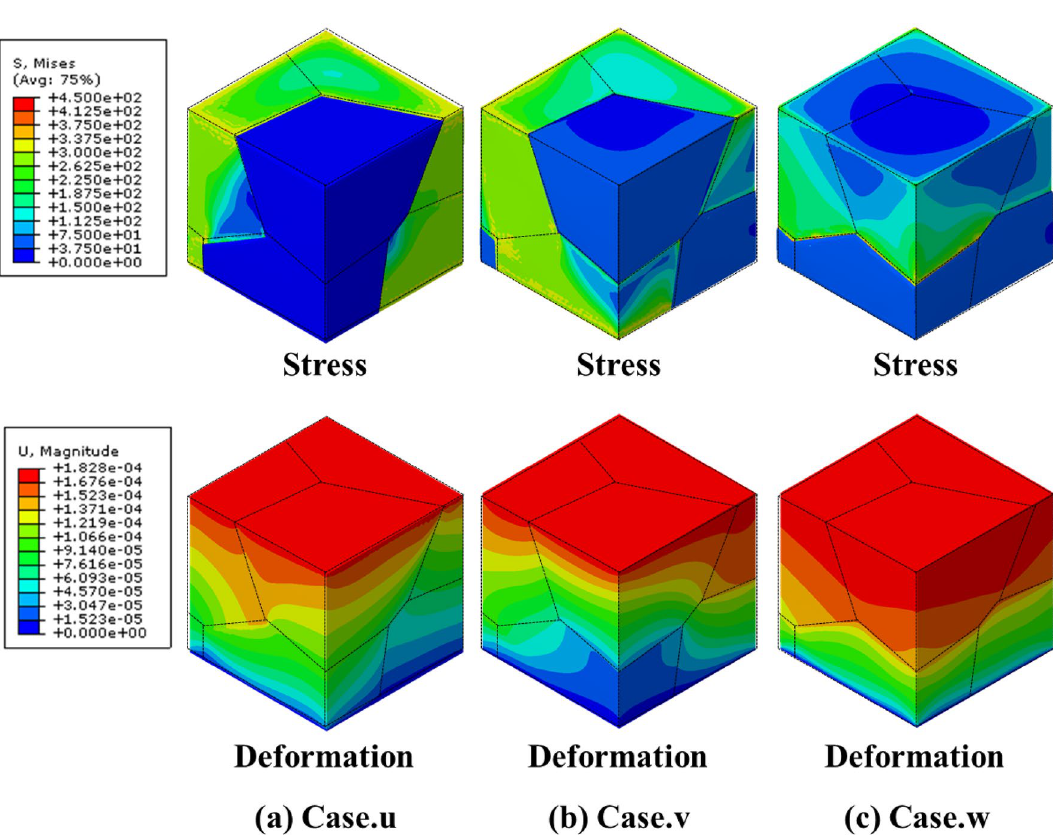
Figure 10. Stress and deformation FEM results of group